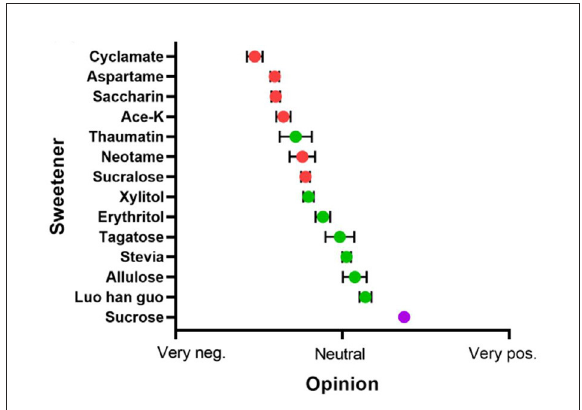
FIGURE3 The popularity of sugar substitutes. Range from very negative (left) to positive (right), Red for artificial sweeteners, green for NSS, and purple for sucrose. Adapted with permission from (15). Copyright 2020,